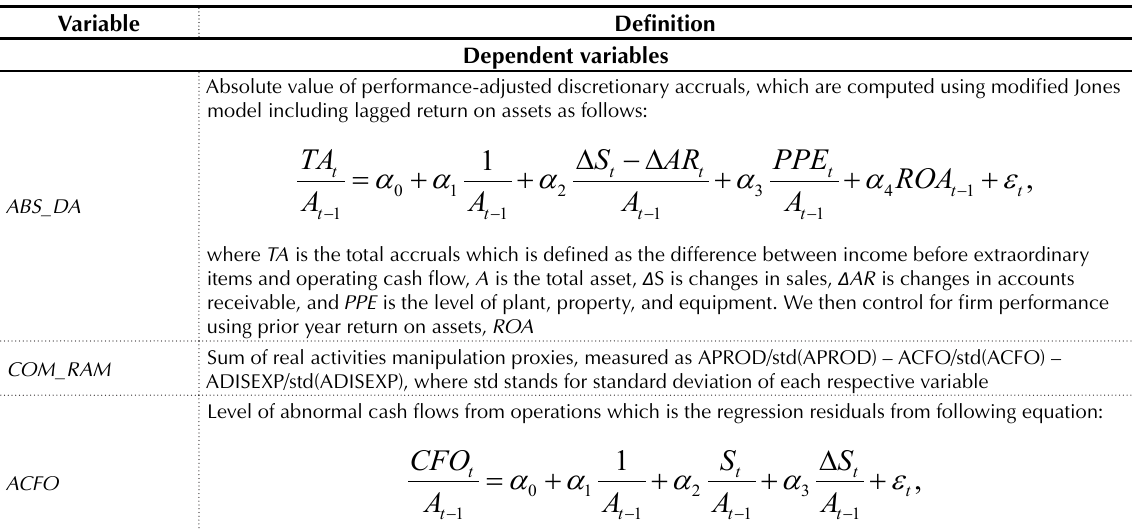
Table A1. Definitions of variables9 Variable Definition Dependent